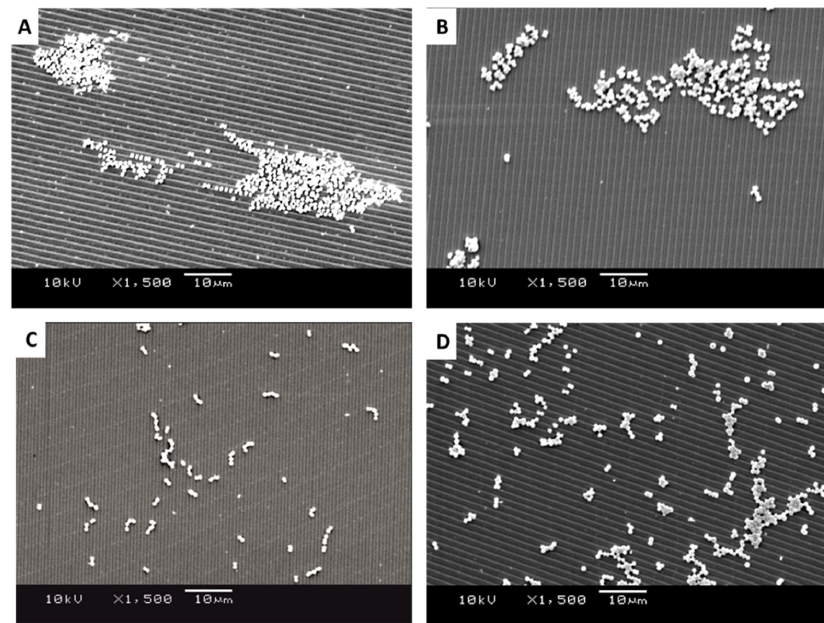
Figure 5. SEM images of retained bacteria on silica plates with titanium-coated grooves (1.02 µm): ( A ) S. aureus , ( B ) M. luteus , ( C ) Strep. pyogenes , and ( D ) S. sciuri .